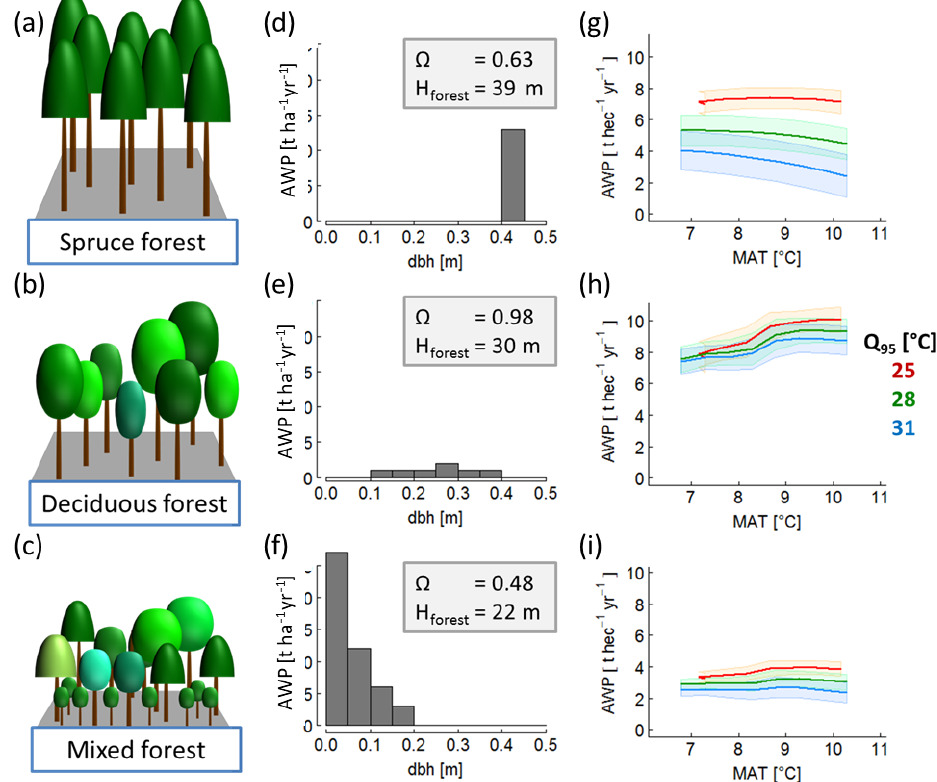
Figure 2. Overview of forest properties and resulting temperature sensitivity of AWP of three exemplary forests: (a) old even-aged spruce forest; (b) mature deciduous forest; (c) a quite young mixed species forest. The middle (panels d , e and f ) shows the corresponding stem size distributions and provides information on the highest tree in the forest ( H forest ) and species distribution index (cid:127) AWP (which quantifies the suitability of a species distributed within the forest structure with regard to AWP). Each forest is treated with 320 climate time series; the last column (panels g , h and i ) shows the AWP as a function of mean annual temperature (MAT). The colours indicate different inter-annual temperature amplitudes ( Q 95) of the used time series. (The coloured bands show the standard deviation due to the variability of the five different time series that exist for each combination of mean annual temperature and intra-annual temperature